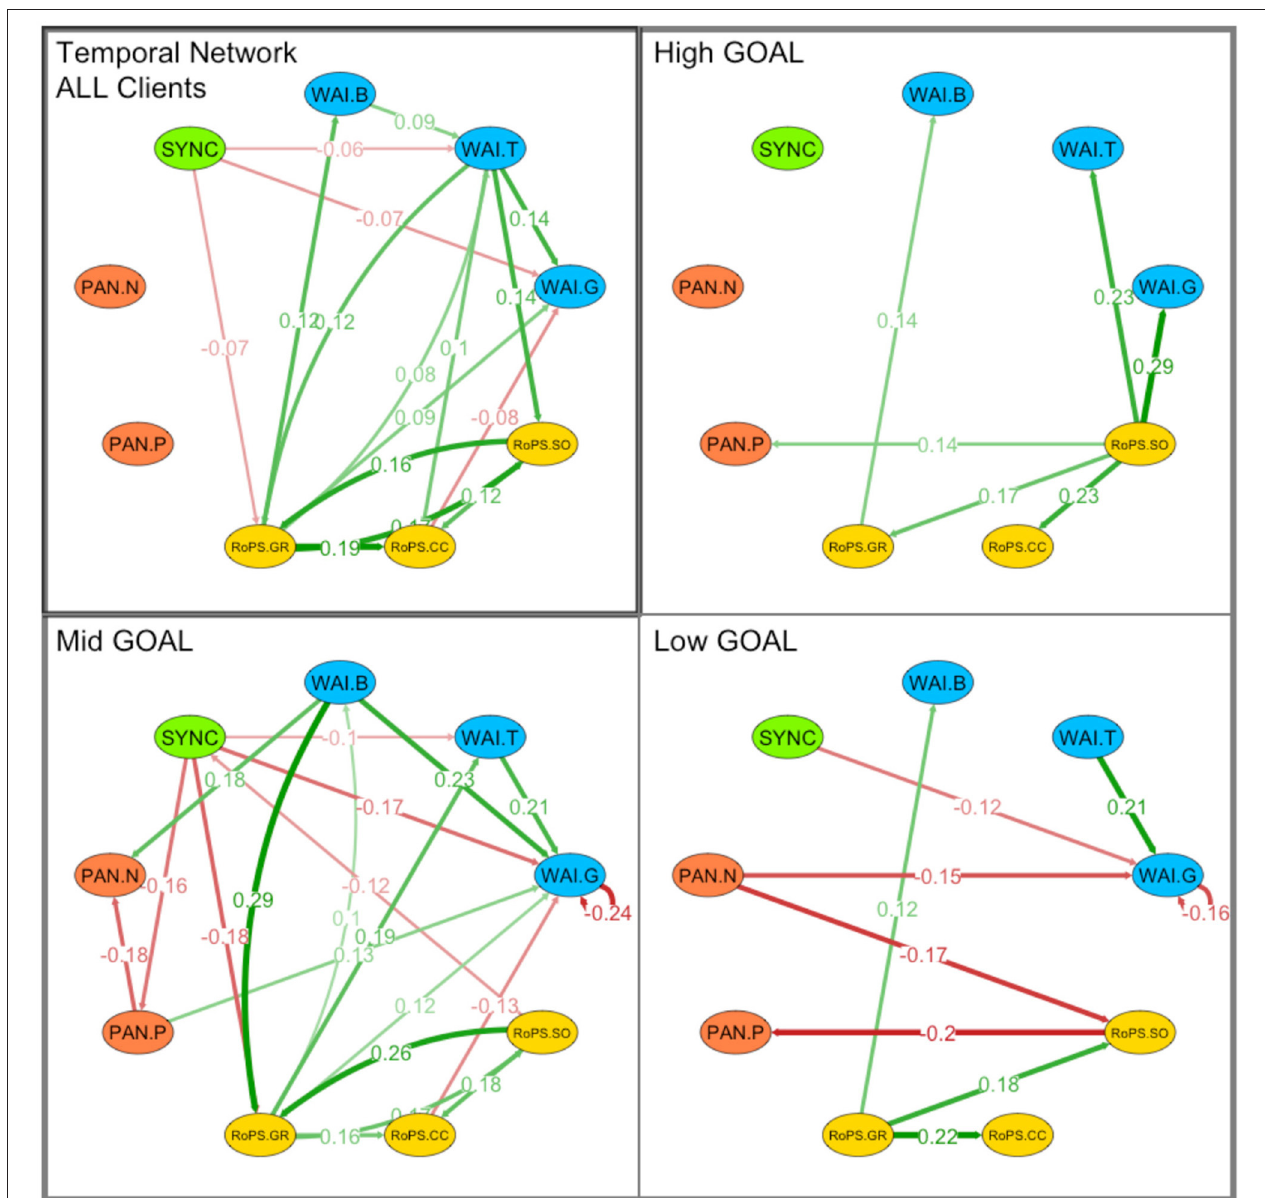
FIGURE 9 | Network analyses: Temporal associations between synchrony (SYNC), working alliance (WAI), affective experience (PAN), and cognitive self-regulation (RoPS). Associations highlight nodes between the following variables: WAI.B, Bond; WAI.T, Task Setting; WAI.G, Goal Orientation; RoPS.SO, Self-Organization; RoPS.CC, Concrete Changes; RoPS:SO, Self-Organization; PAN.P, Positive Affect; PAN.N, Negative Affect; Associations are clustered by “ALL Clients” as well as groups of High GOAL attainment, Mid GOAL attainment, and Low GOAL attainment. Green-colored connections: Positive associations. Red-colored connections: Negative associations. Thickness of lines: Strength of association. Only significant associations